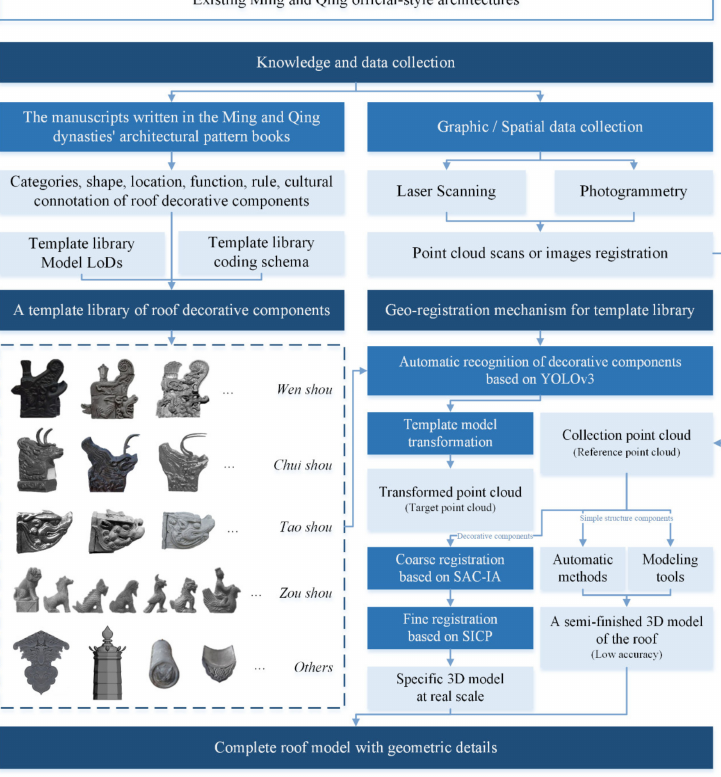
Figure 2. The workflow for reconstructing 3D roof model using the template